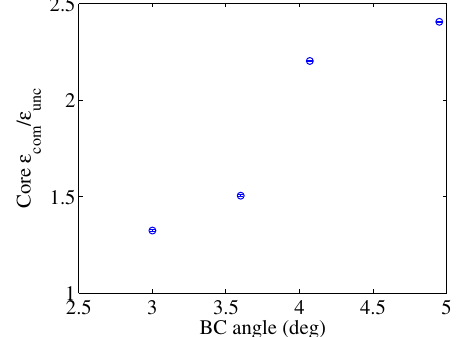
FIG. 3. Measured relative core emittance increase versus the bunch compression factor extracted from the data shown in Fig. 2.